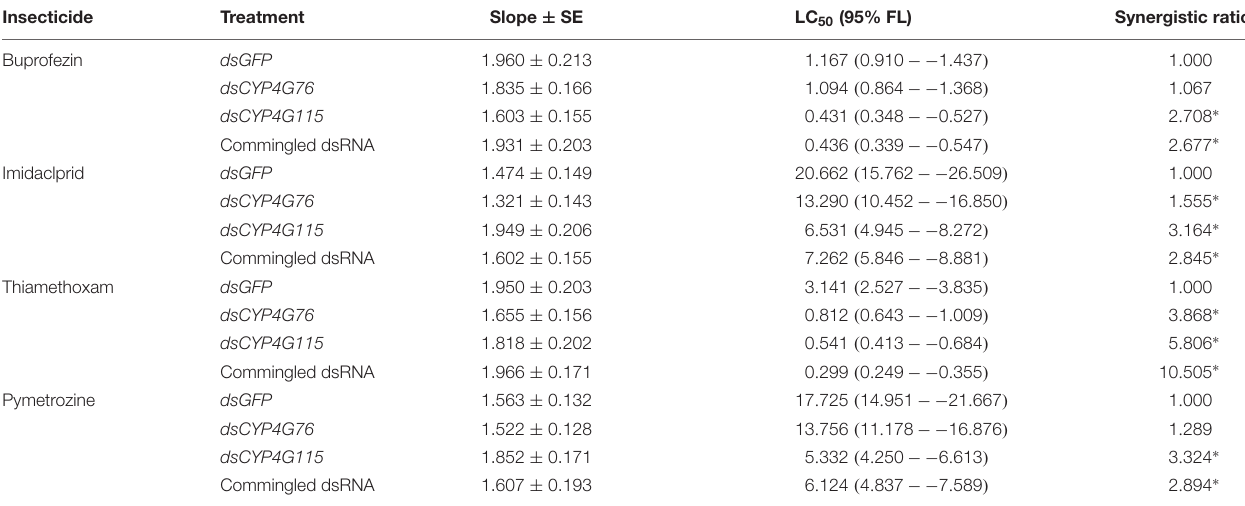
FL, fiducial limits. ∗ in each figure showed the significant difference (ANOVA, LSD, p < 0.05).